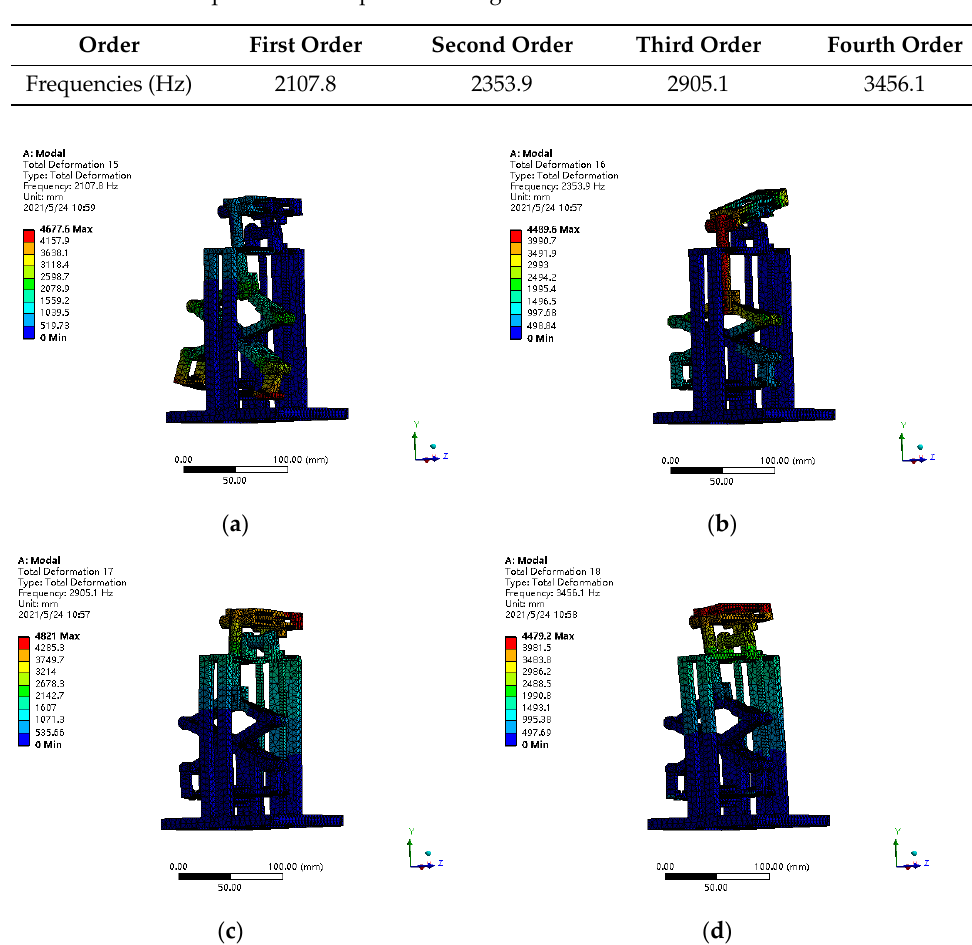
Table 3. Natural frequencies of the piezoelectric generator.